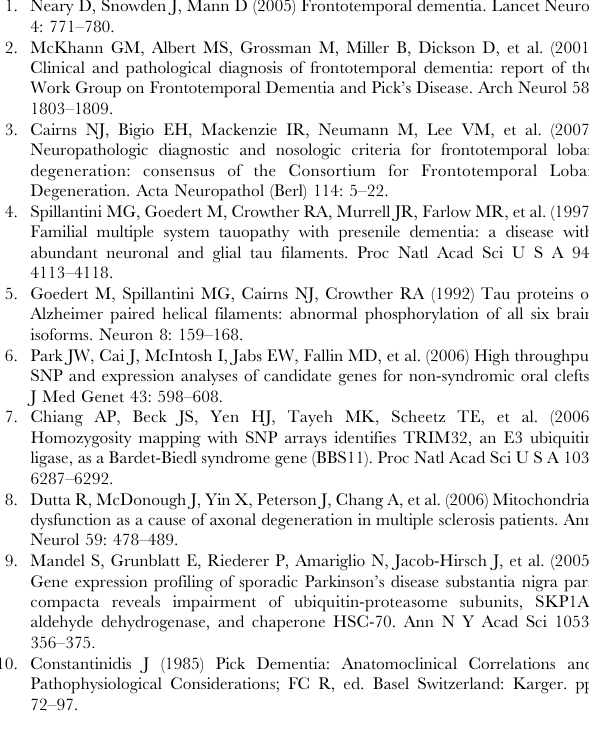
Table S5 Primer sequences of primers used for quantitative reverse transcriptase confirmation of the microarray